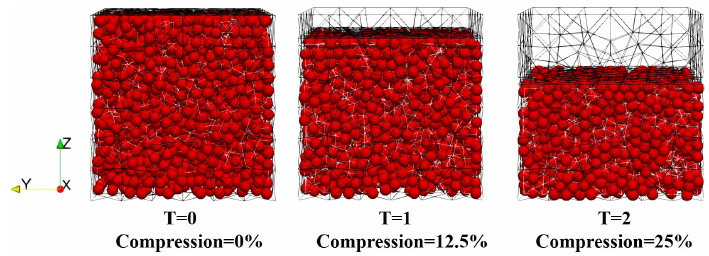
Figure 8. Compression of particles.